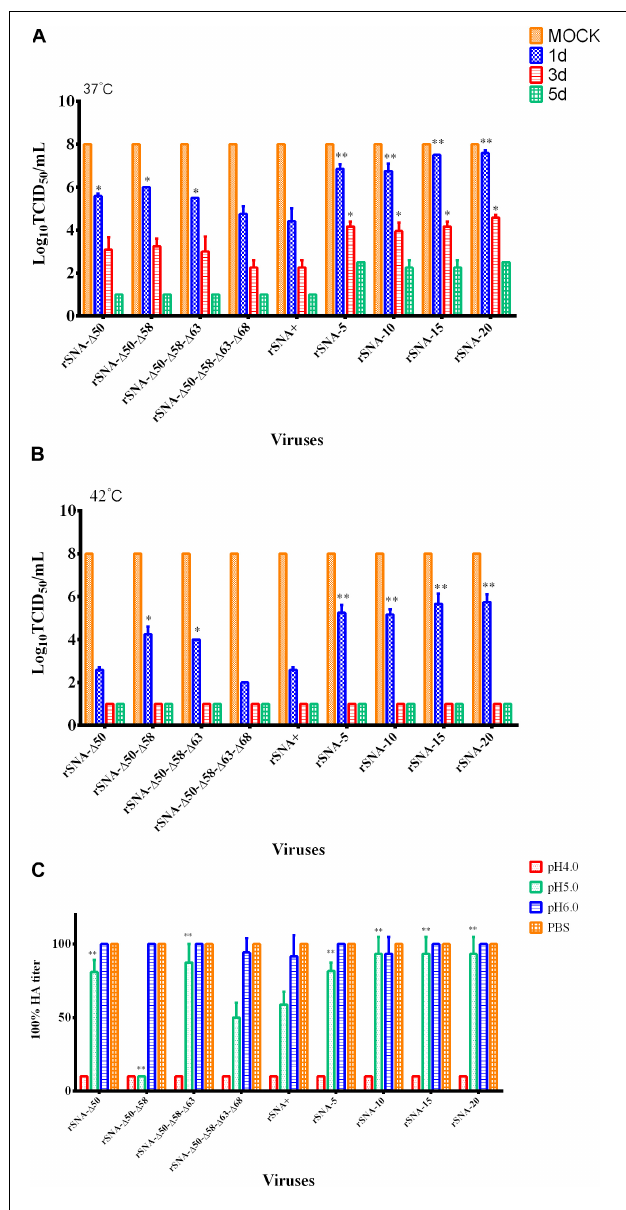
FIGURE 4 | Thermal stability of the recombinant viruses at 37 ◦ C (A) , 42 ◦ C (B) , and low-pH stability of them (C) . * P < 0.05, ** P < 0.01, compared to the value of the